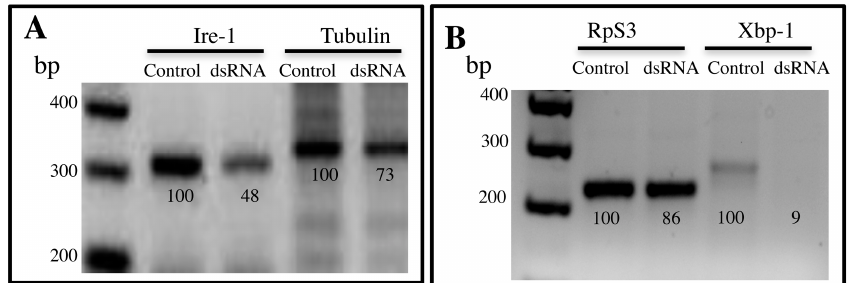
Figure 2. Silencing of IRE-1 branch of UPR pathway by RNAi in Aedes aegypti larvae. ( A ) The expression of ire -1 gene was analyzed by RT-PCR assays in larvae that were feed with ire 1-dsRNA and in control larvae; ( B ) The expression of xbp -1 gene was analyzed by RT-PCR assays in larvae that were feed with xbp 1-dsRNA and in control larvae. Numbers under the bands are percentage in relation to the control band, after densitometry analysis. The control bands correspond to non-silenced larvae and were considered as 100%. The expressions of tubulin or rpS3 were used to normalize the results; ( C ) Transcript abundance was determined using qRT-PCR and SYBER green. Bars represent the means and standard errors of three